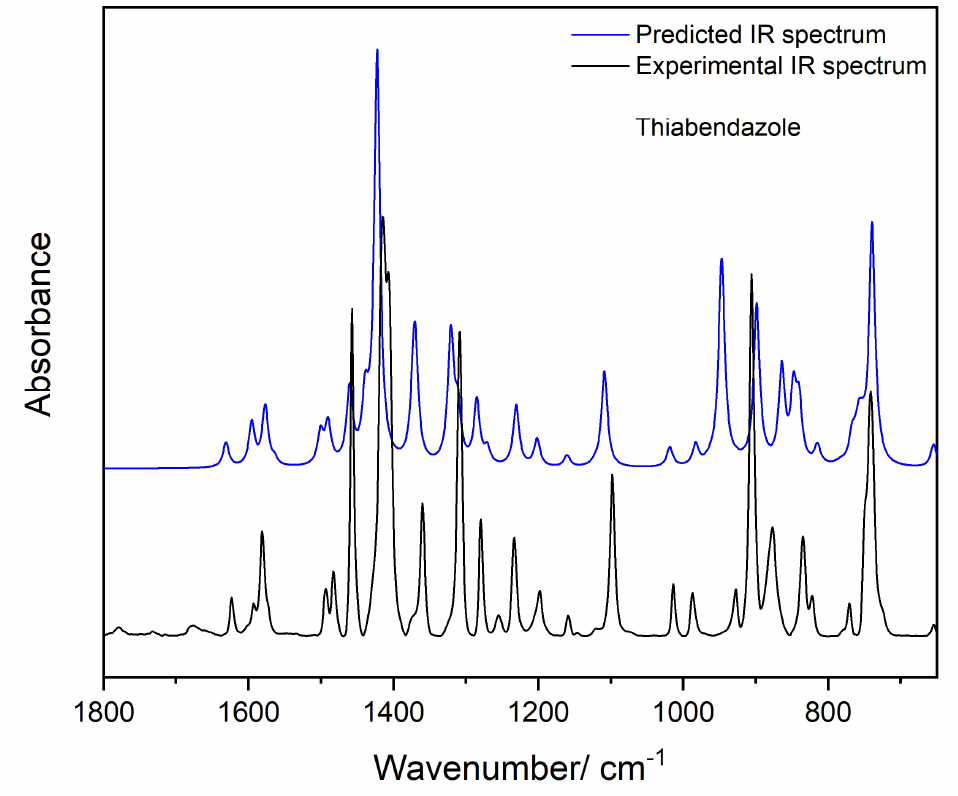
Figure 16. Experimental (black) and periodic B3LYP-D2 / 6-31G(d,p) (blue) IR spectra of TBZ crystal. Predicted frequencies are scaled by 0.972. Table 5. Experimental and B3LYP-D2/6-31G(d,p) calculated infrared frequencies for TBZ crystal with proposed assignments a .